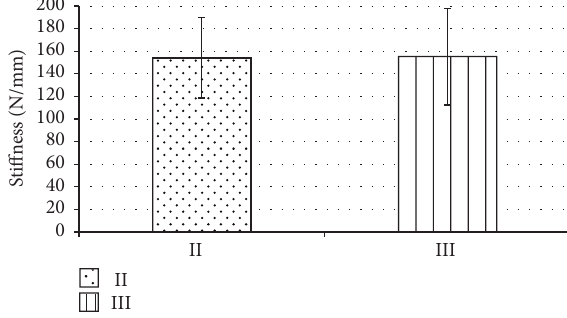
Figure 3: The stiffness was determined for group II (bicortical nonlocking plate) and group III (monocortical locking plate). No statistically significant difference was